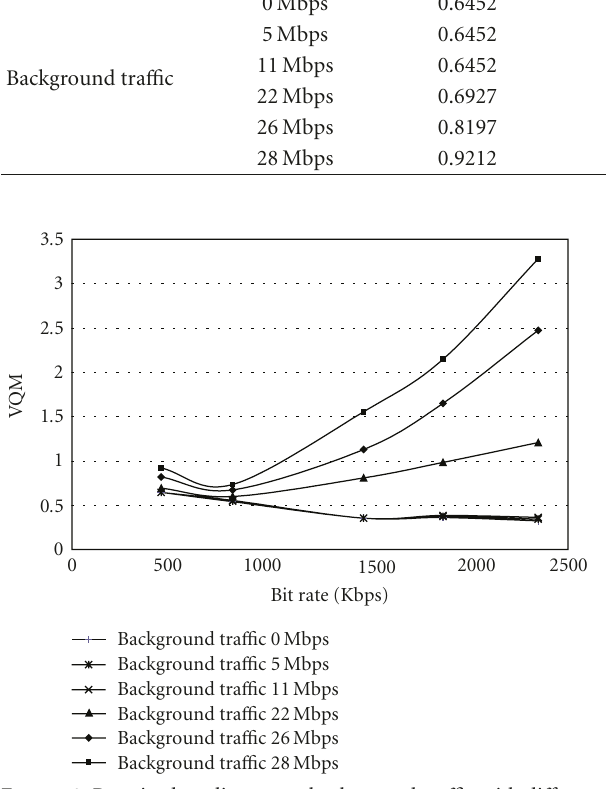
Figure 3: Perceived quality versus background tra ffi c with di ff erent video bit rates.